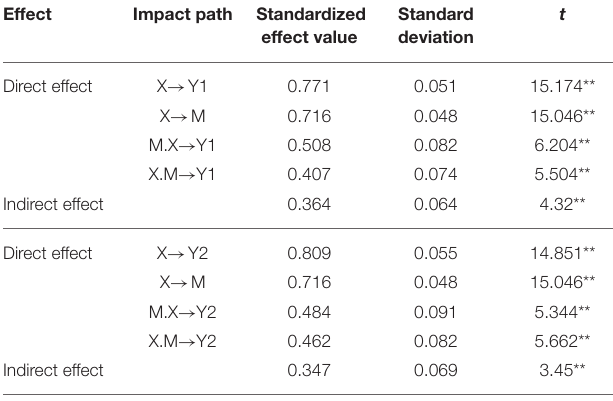
TABLE 4 | Test results of the intermediary effects of commercial